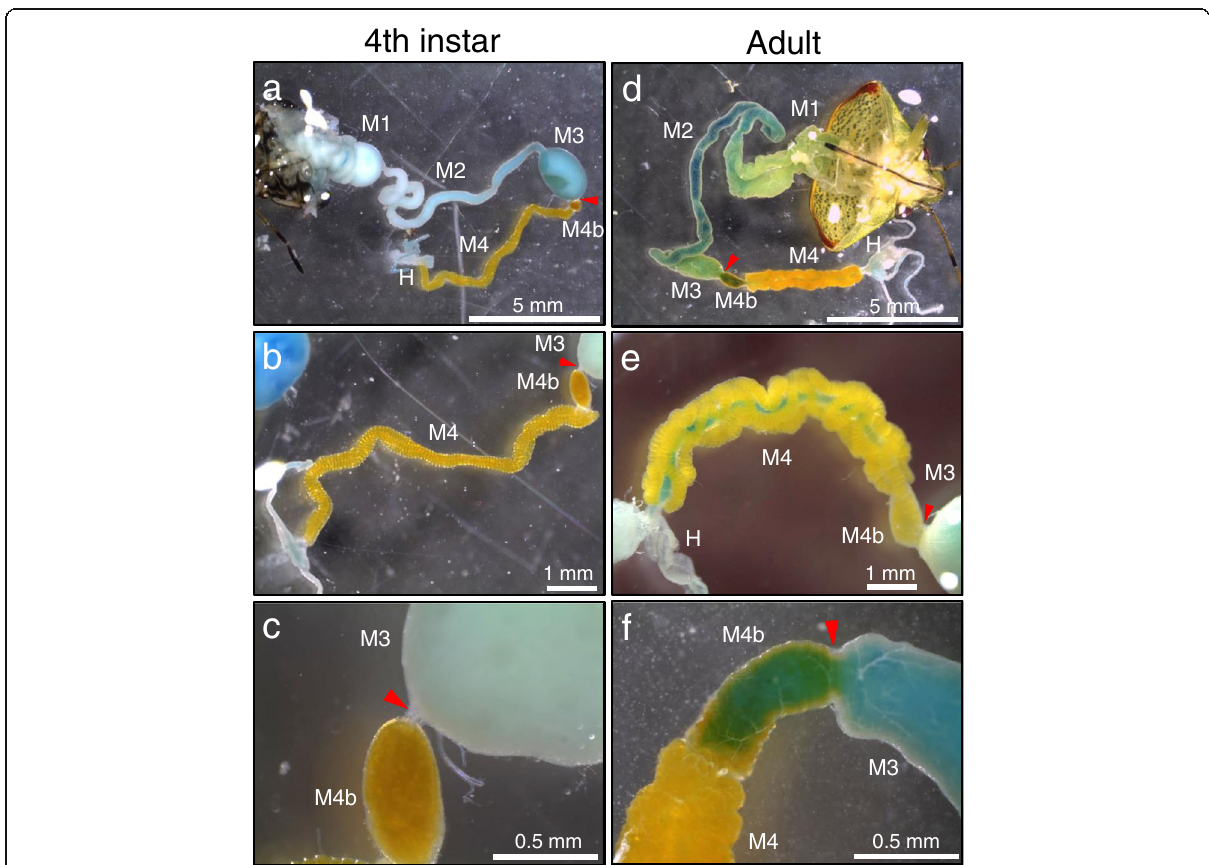
Fig. 7 Alimentary tracts dissected from P. stali fed with colored water containing 0.05% Brilliant Blue FCF. a – c Fourth instar nymphs. d – f Adult insects. a , d Whole alimentary tract. b , e Around the symbiotic M4 region with crypts. Note that the main tract in the M4 region is not colored in the fourth instar nymph but deeply colored in the adult insect. c , f Around the M3 – M4b junction. Red arrowheads indicate the constricted region that functionally separates the anterior and posterior regions of the midgut as a symbiont sorting organ that blocks food flow to the posterior midgut [44]. Abbreviations: M1, midgut first section; M2, midgut second section; M3, midgut third section; M4b, bulb-like region aboral to M4; M4, midgut fourth section with crypts; H,